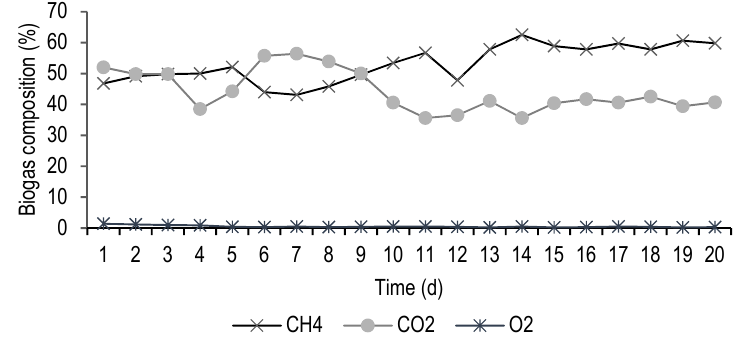
Figure 5. Biogas composition monitoring over the co-digestion process of C-7.